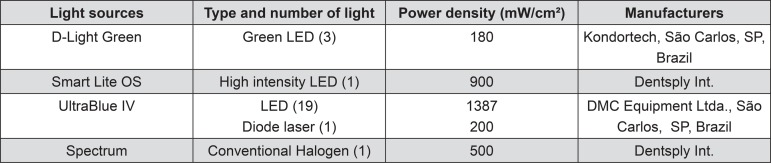
Light units studied